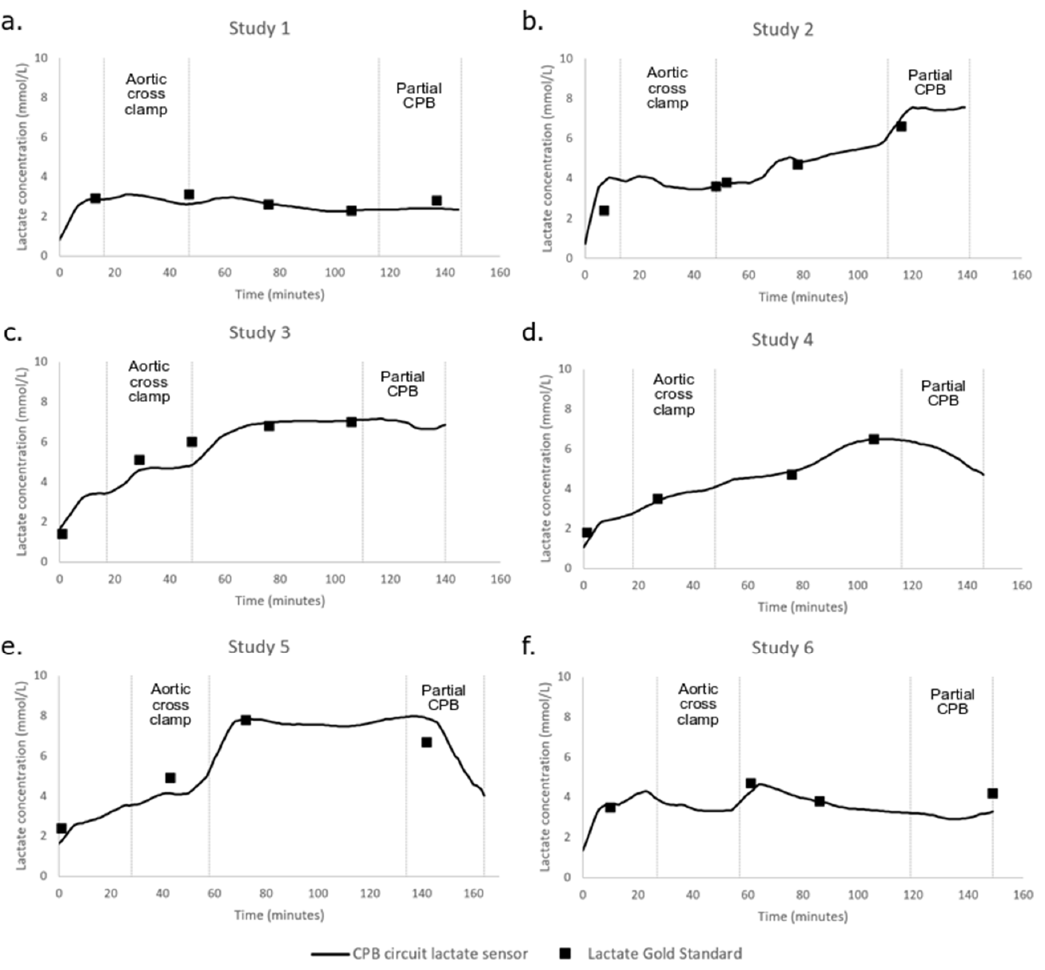
Figure 2. Continuous time trace of continuous lactate sensor measurements conducted in the cardiopulmonary bypass (CPB) circuits of the piglets in vivo (solid lines) compared to the